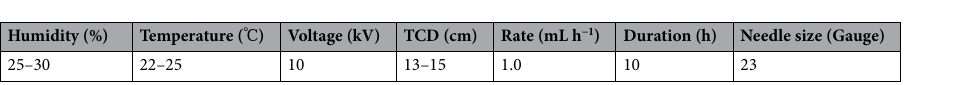
Table 1. Electrospinning condition for preparation of nanofibers.